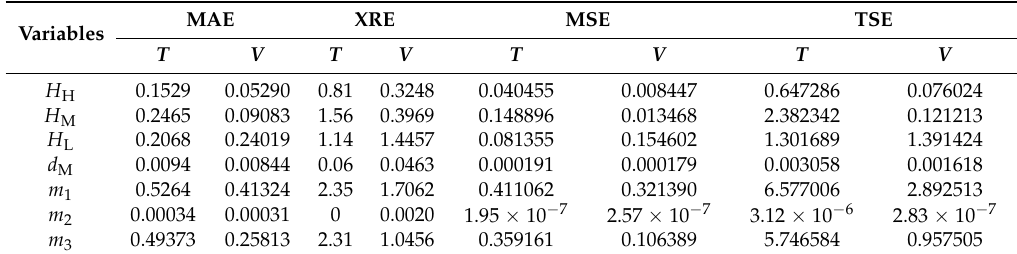
Table 5. Model performance criteria summary using the geometrical